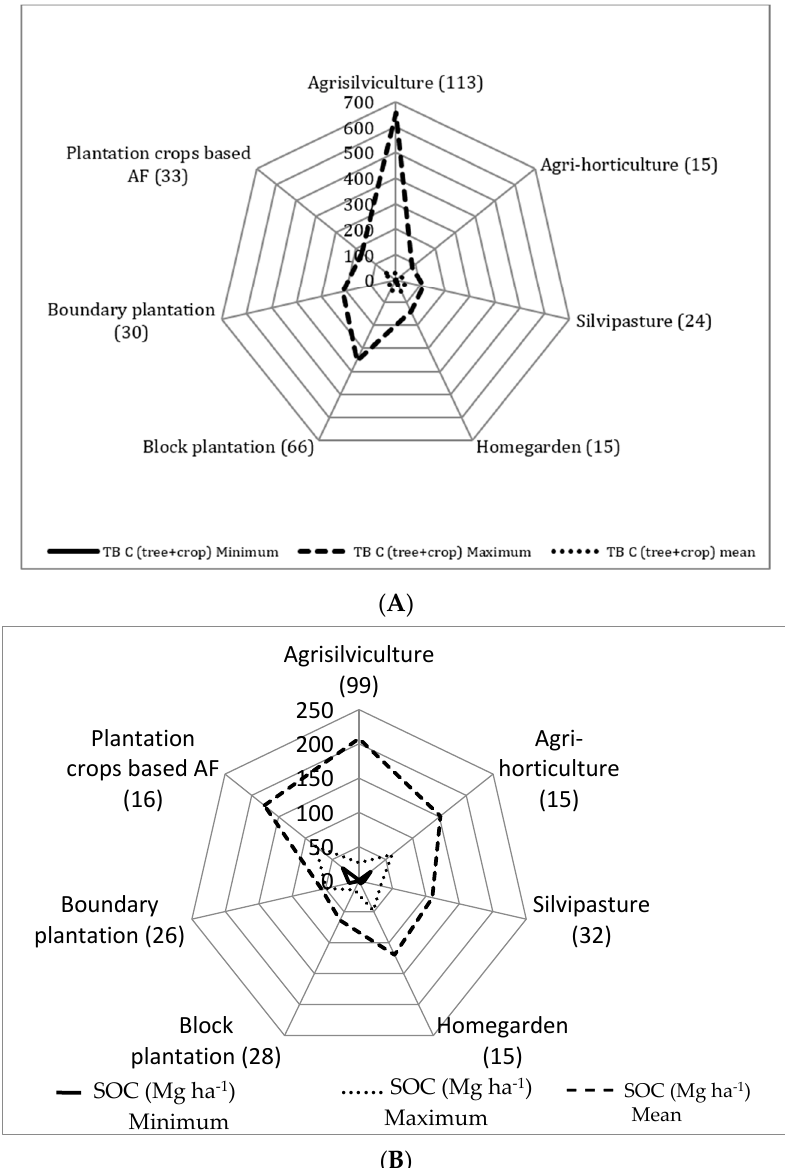
Figure 3. TBC ( A ) and SOC ( B ) in different AFS in India. ( A ) Total biomass carbon (Mg ha − 1 ); ( B ) Soil Organic Carbon (Mg ha − 1 ).